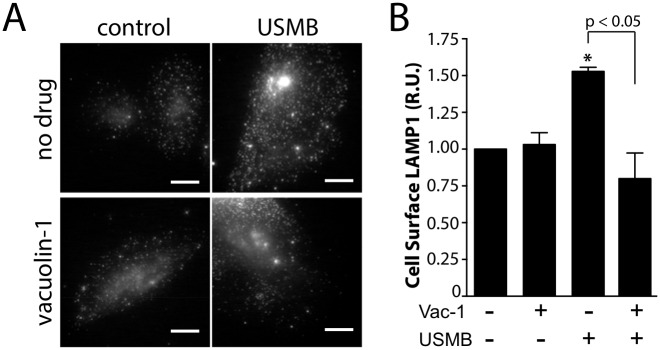
USMB treatment increases the cell surface abundance of the lysosomal marker LAMP1.RPE cells grown on glass coverslips were treated with 5.0 μM vacuolin-1 for 60 min, or not treated with this inhibitor (vehicle control). Cells were subsequently treated with USMB or left untreated (control) as indicated. Following treatment, cells were immediately placed on ice to arrest membrane traffic and subjected to immunofluorescence staining to detect cell surface LAMP1 levels. Shown in (A) are representative epifluorescence micrographs of cell surface LAMP1 levels and in (B) the mean ± SEM of cell surface TfR fluorescence intensity in each condition (n = 3 independent experiment, each experiment >20 cells per condition). Scale = 20 μm. *, p < 0.05 relative to the control, vehicle-treated condition.